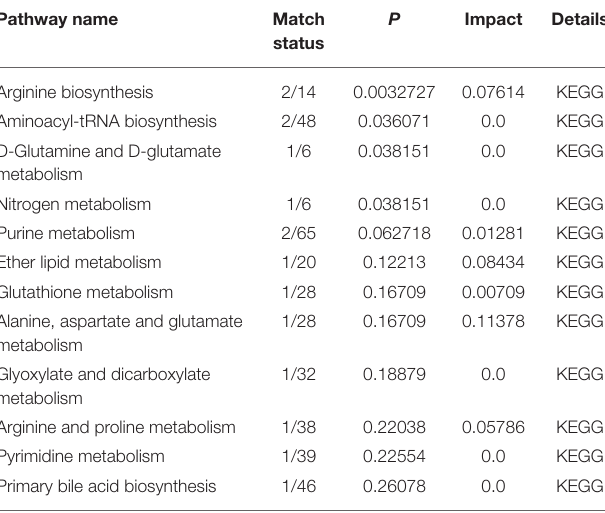
TABLE 5 | Results of metabolic pathway enrichment